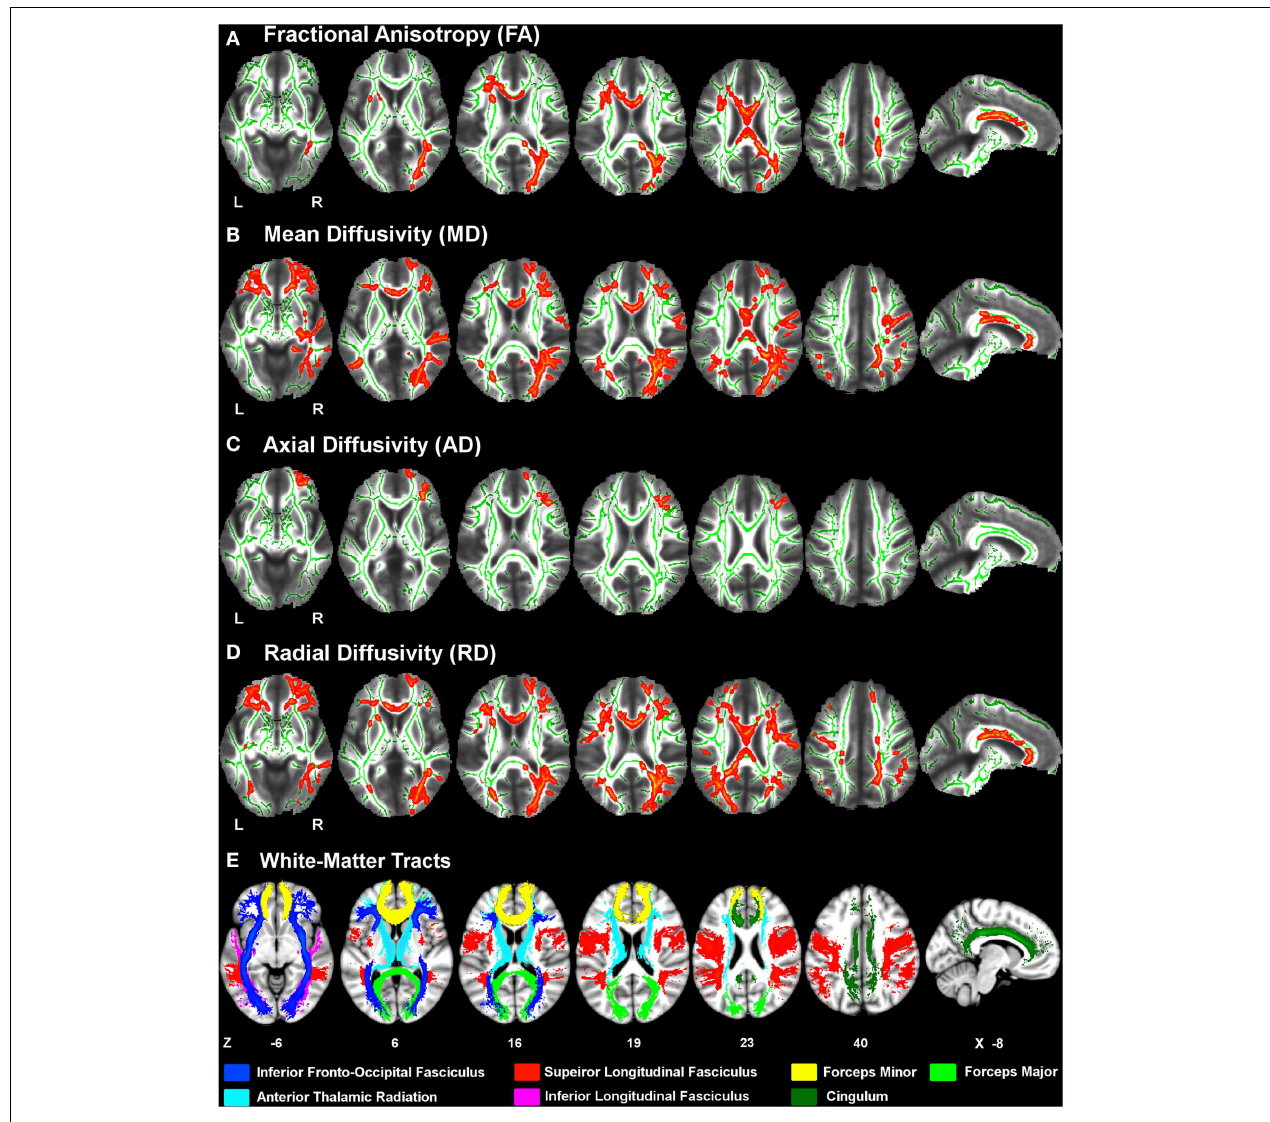
to increase their visibility.White-matter tracts (E) showing significant diffusivity changes in PD were specified using the Johns Hopkins University (JHU) white-matter tractography atlas. Color labels for the JHU tracts are displayed at the bottom. Z coordinates (mm) of slices are from the Montreal Neurological Institute atlas. L, left hemisphere; R, right